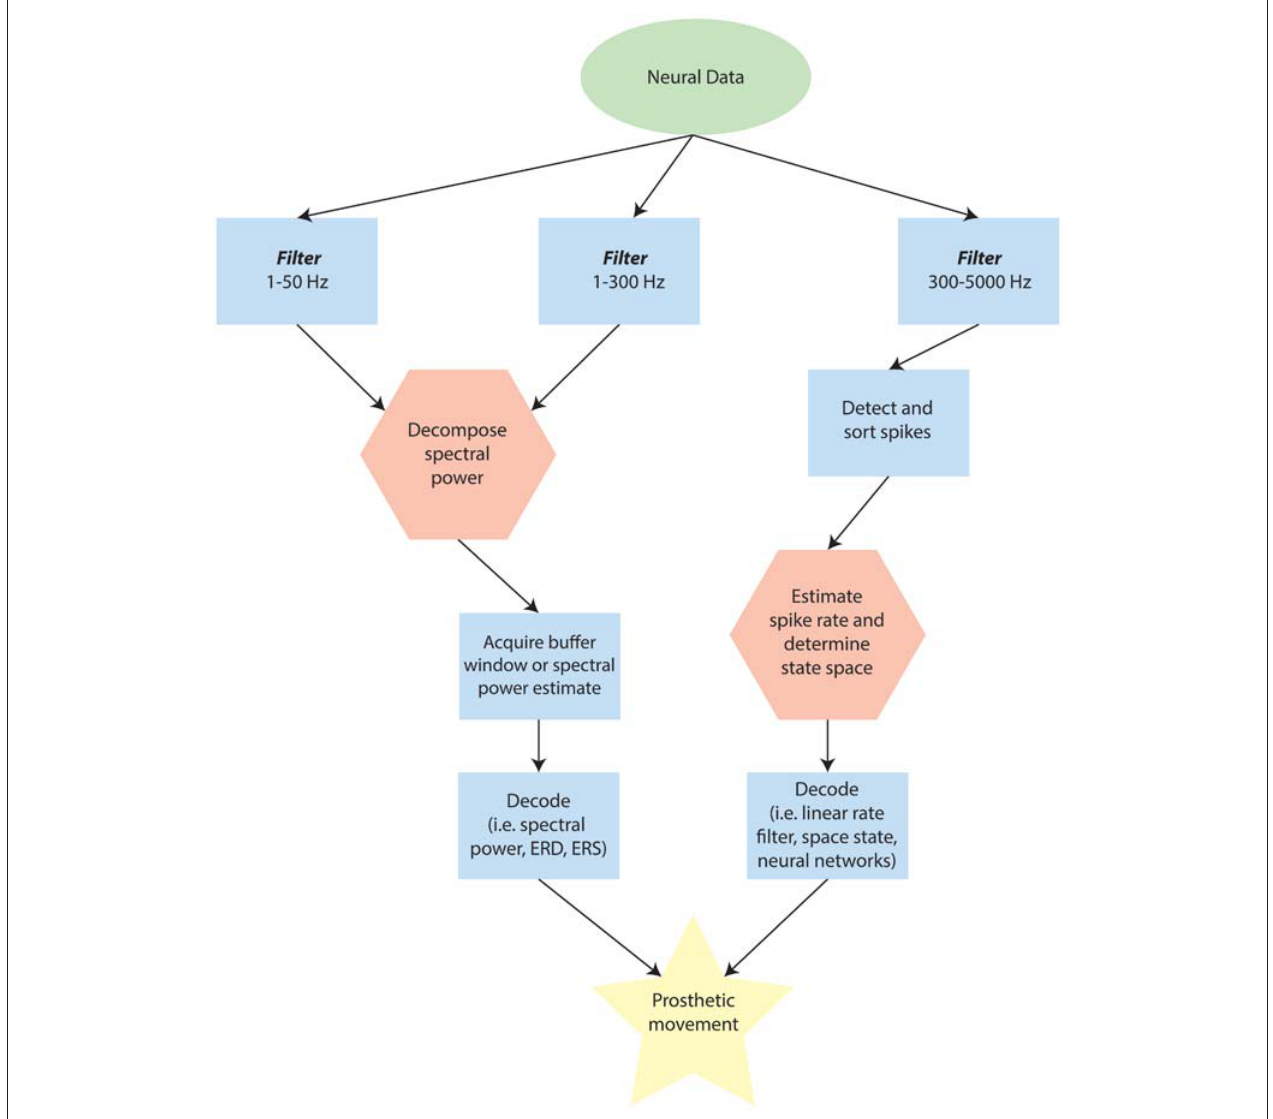
FIGURE 2 | Schematic of possible differences in analysing point-processes and waveforms when using externally interfaced motor prosthetics. Note that this flow may change depending on the specific device, but is designed to provide a broad overview for comparison. In the diagram, the green ellipse represents data that has been recorded and amplified from the neural source. Blue rectangles are stages along the processing pathway that are typical for many devices. Red hexagons represent potential rate-limiting steps in determining the latency of the Brain Computer Interface (BCI) response to immediate internal changes in patterns of neural